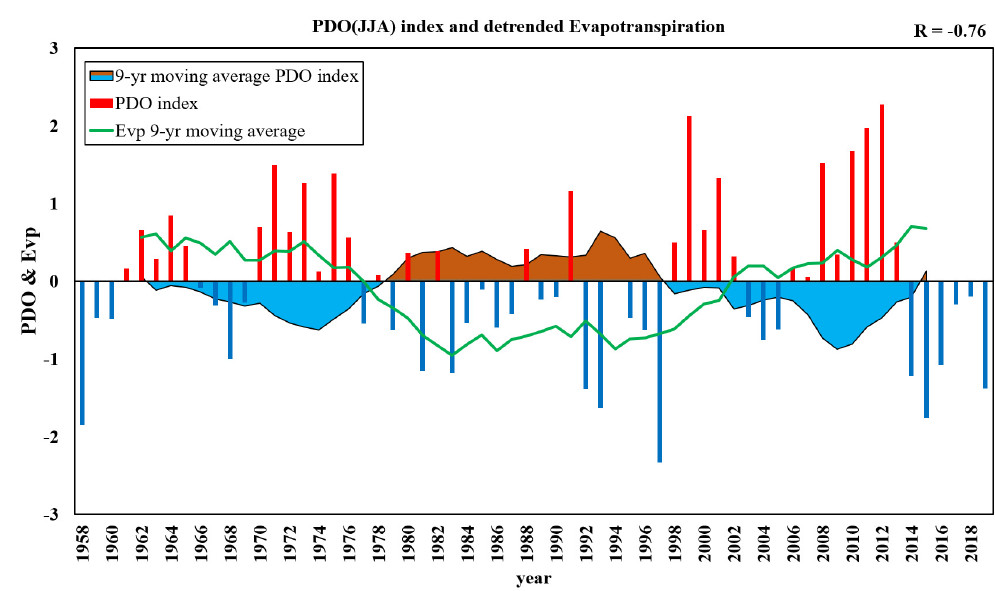
Figure 4. Time series of the evapotranspiration in the TP, and the PDO index during the period of 1958 to 2019.